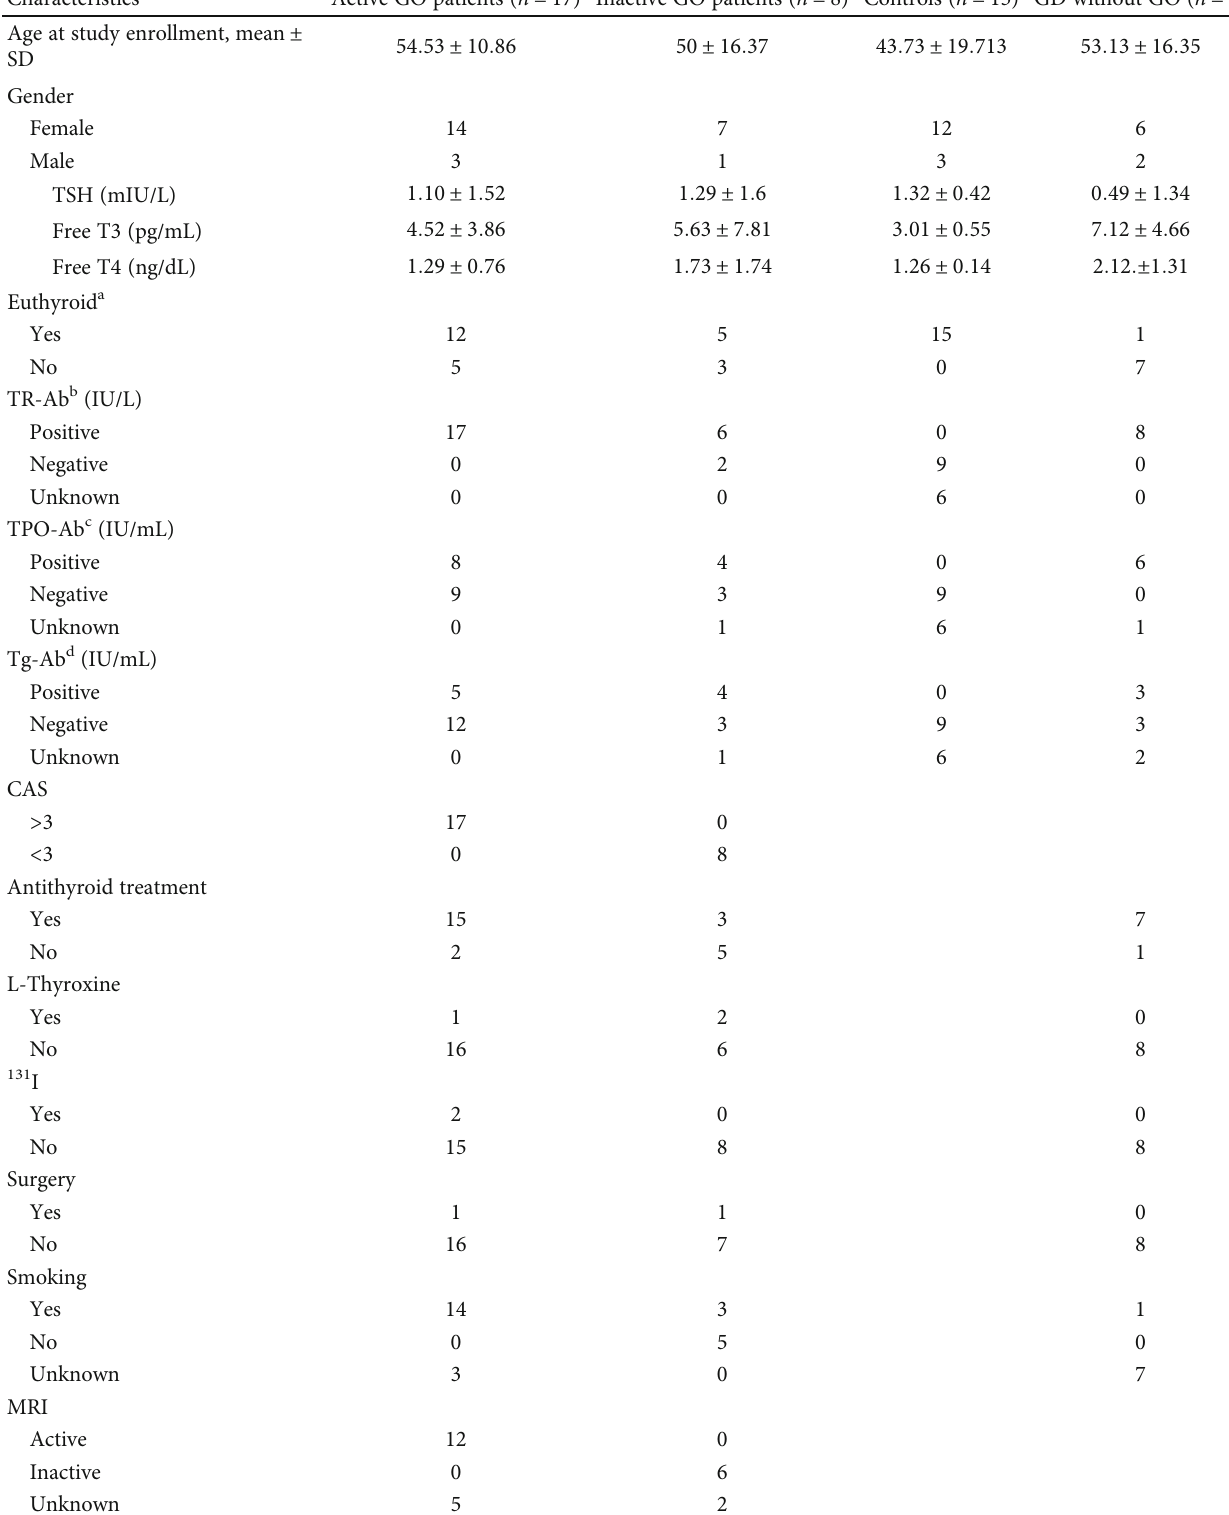
Table 1: Characteristics of patients and controls included in the study.